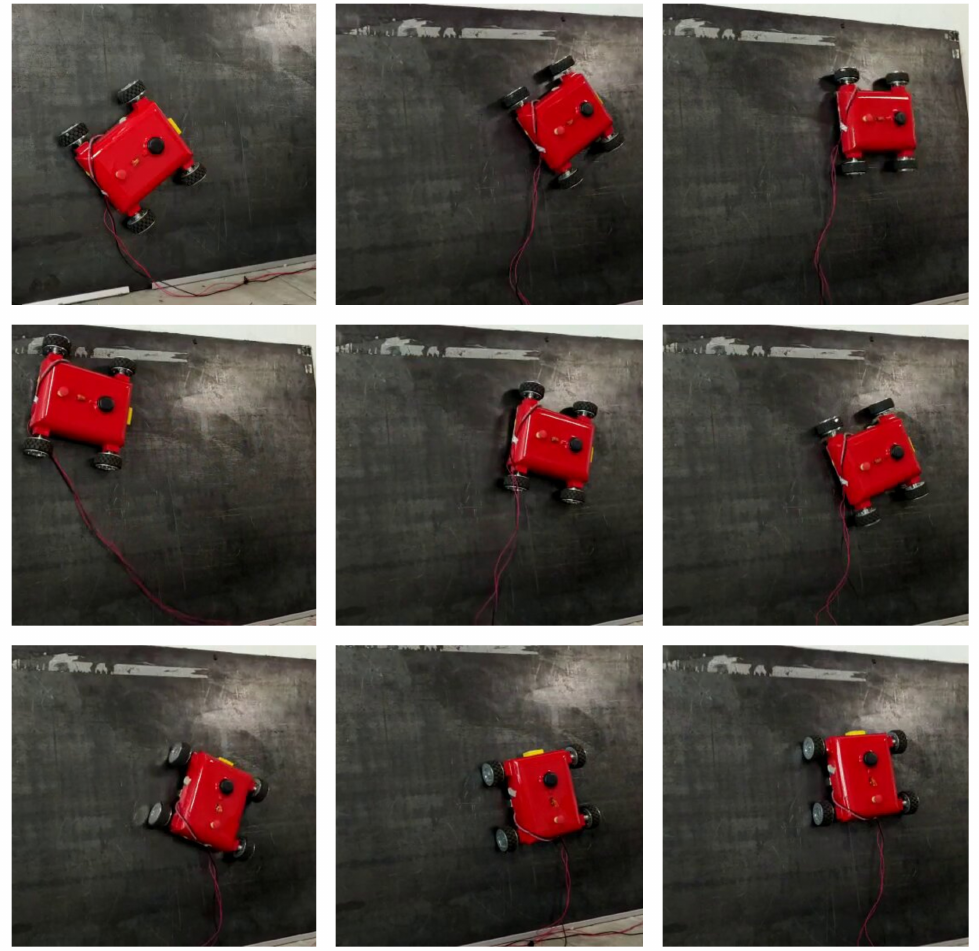
Figure 9. Sparrow robot during the trials on metal